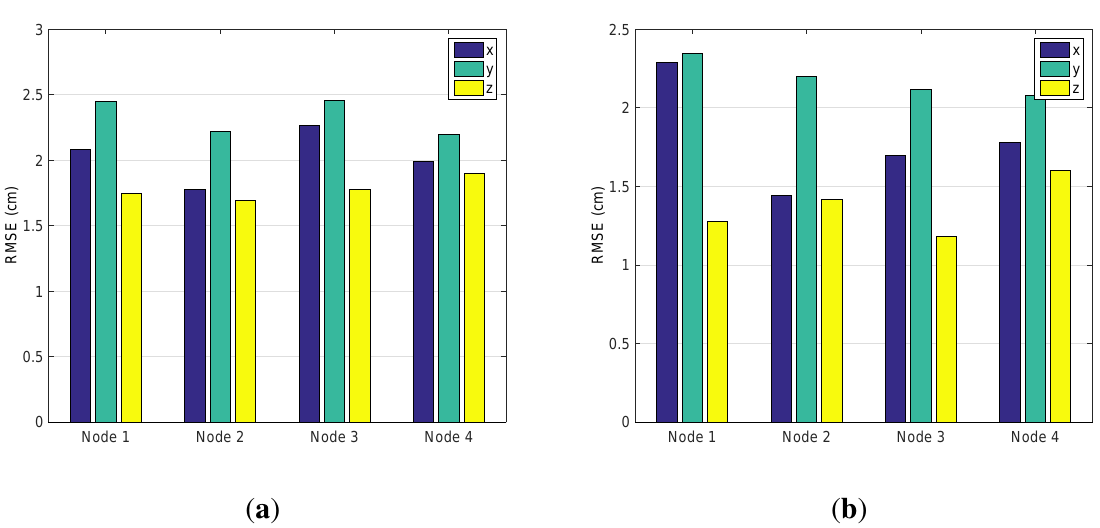
Figure 15. The comparison of the average error. ( a ) The average error of Cayley–Menger; ( b ) the average error of